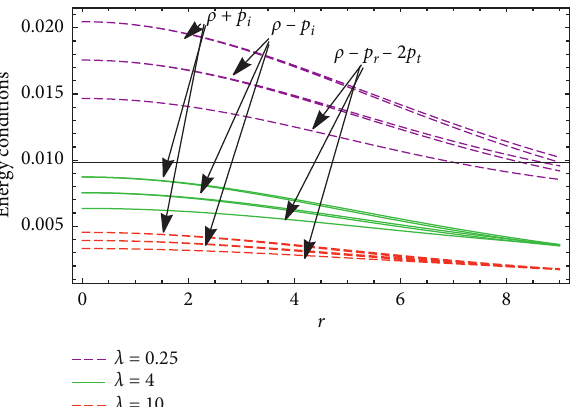
Figure 6: Left panel shows the behavior of d ρ values.